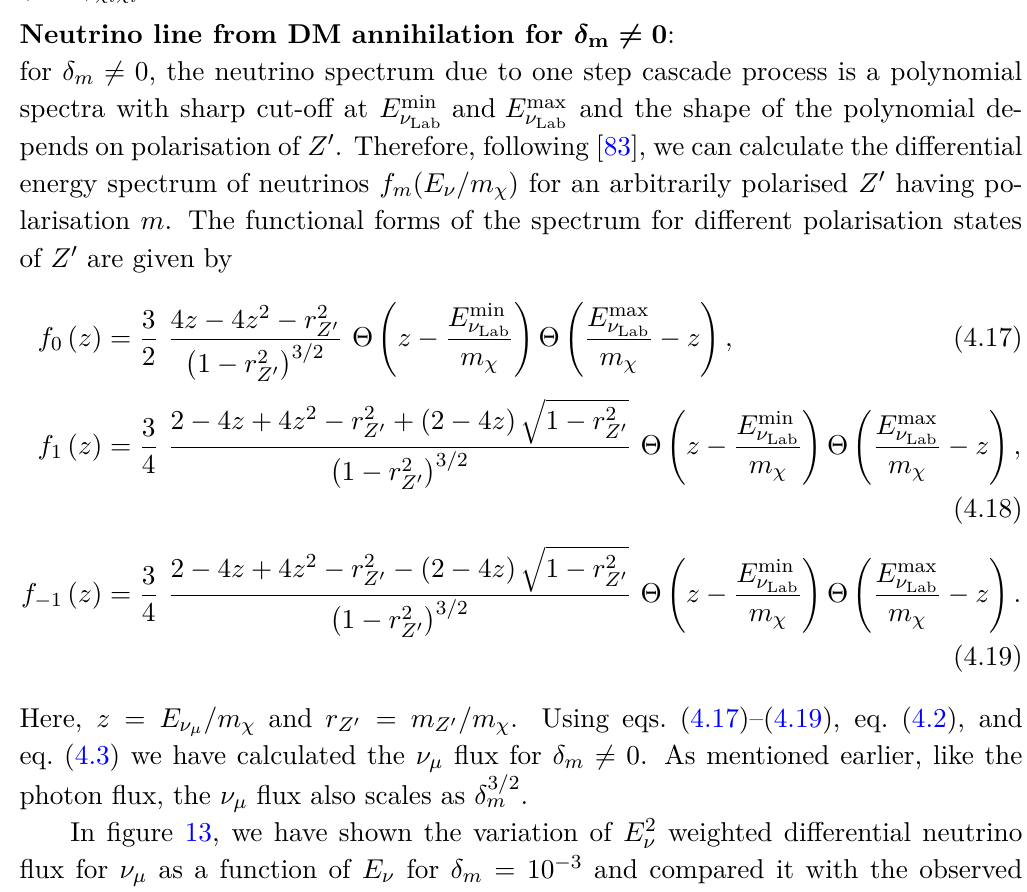
Figure 13 . Variation of E 2 with 1 σ errorbars are the atmospheric ν